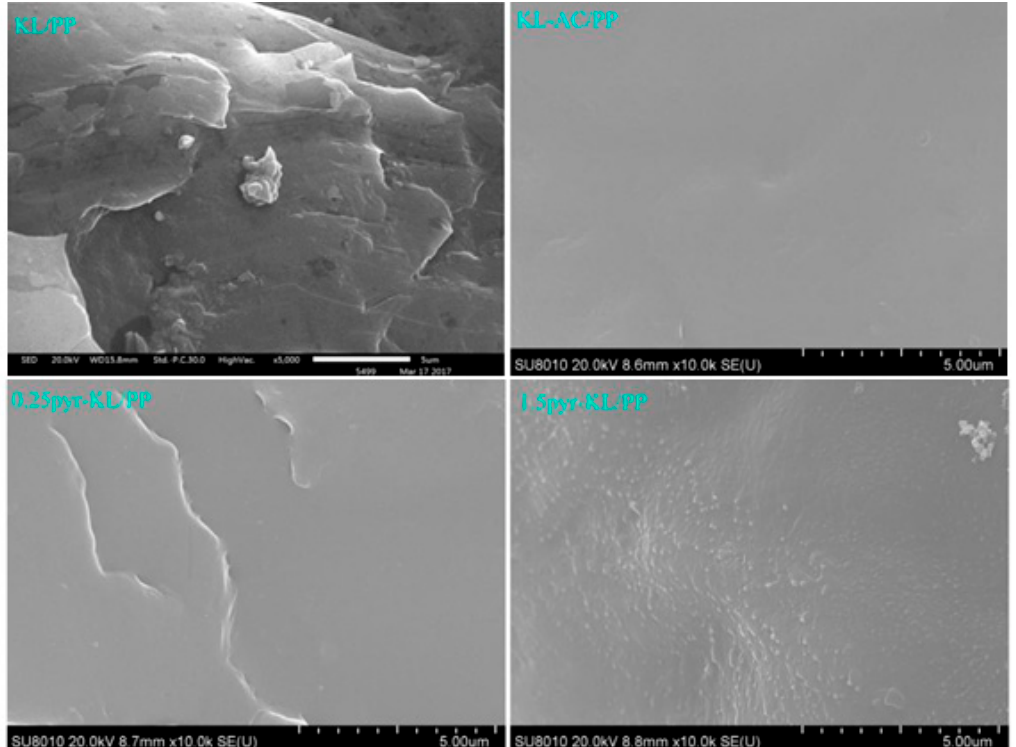
Figure 8. SEM micrographs of polypropylene blending with 0.5 wt% Kraft lignin and its derivatives. (AC: acetylated, 0.25 pyr-KL and 1.5 pry-KL contain 1.07 mmol / g and 3.07 phenolic-OH, respectively). Reprinted from [61] with permission from Elsevier ©